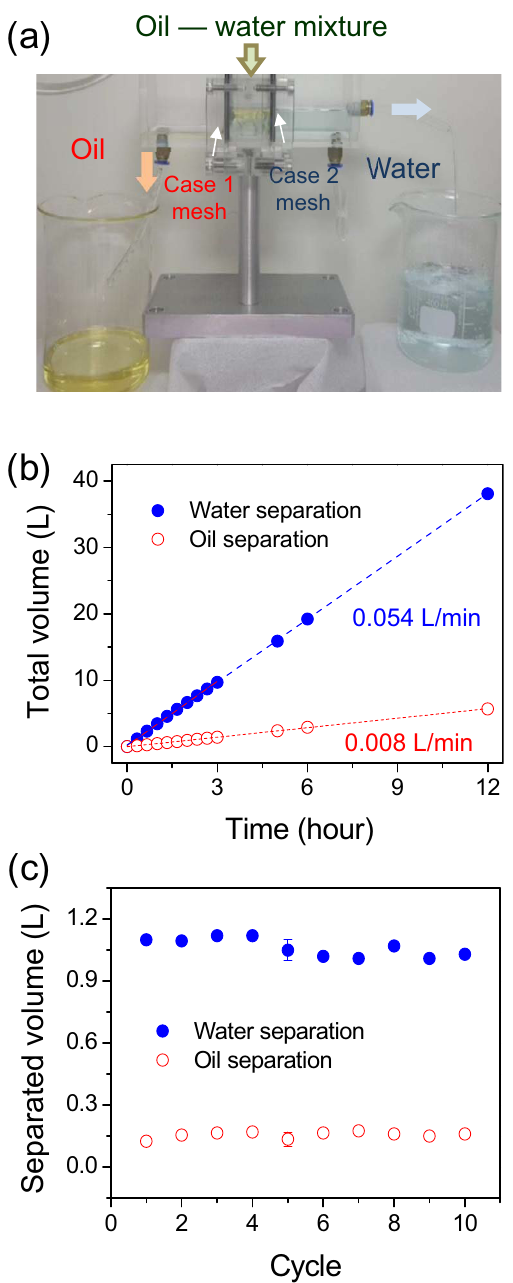
Figure 4. ( a ) Picture of the device during continuous and simultaneous oil–water separation experiment. Water was dyed with methylene blue. ( b ) Measurements of accumulated volumes of separated oil and water during a 12-h separation process. ( c ) Cyclic test of separating stability by collecting the separated liquid for 20 min